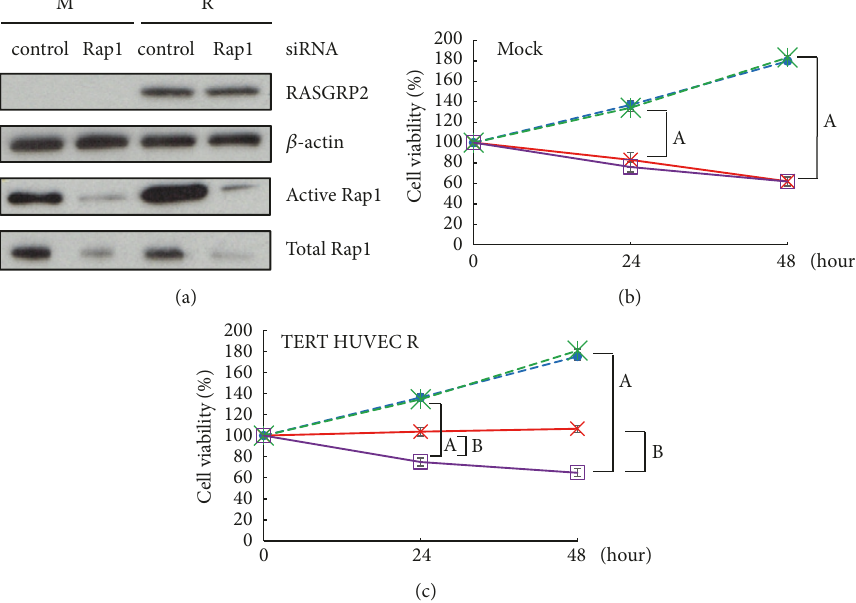
Figure 6: Effect of Rap1 siRNA on TNF- 𝛼 stimulation. (a) Activated Rap1 in TERT HUVEC under Rap1 siRNA conditions was recovered using RalGDS-RBD agarose beads and validated by western blot. M: mock cells; R: TERT HUVEC R cells. (b) and (c) represent the cell viability of mock cells and TERT HUVEC R cells in TNF- 𝛼 stimulation under condition Rap1 knocked down. Blue circle: control siRNA; red cross: control siRNA + TNF- 𝛼 ; green asterisk: Rap1 siRNA; purple square: Rap1 siRNA + TNF- 𝛼 ; n=3; A = P < 0.01, Rap1 siRNA versus Rap1 siRNA + TNF- 𝛼 ; B = P < 0.01, control siRNA + TNF- 𝛼 versus Rap1 siRNA + TNF- 𝛼